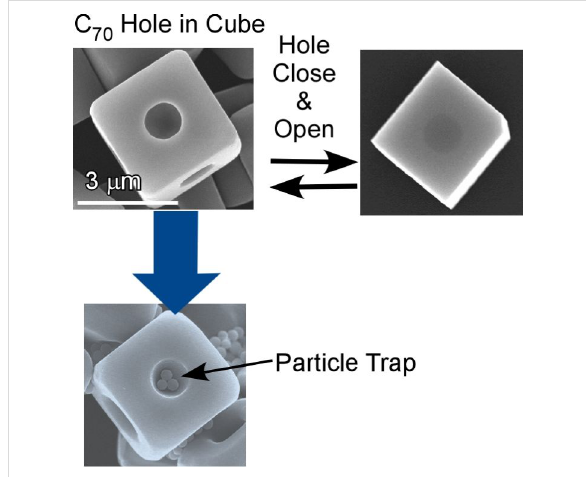
Figure 22: Hole-in-cube structures made from C 70 molecules with hole closing and re-opening and particle-trap capability. Reproduced from [75], copyright 2019 The